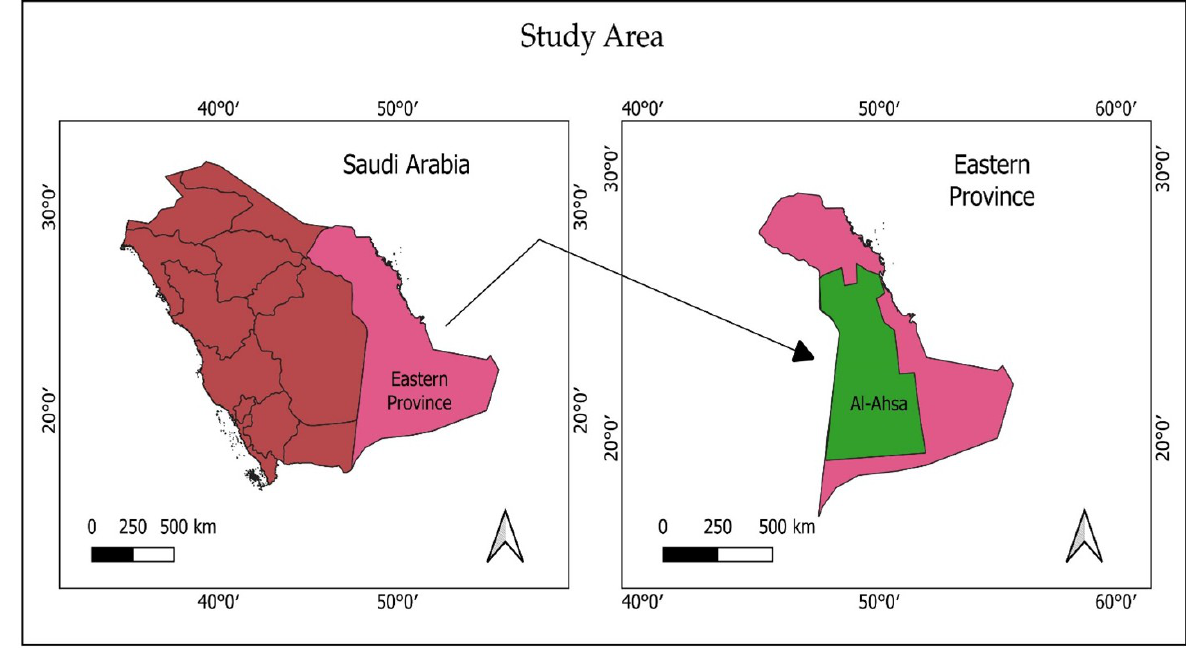
Fig 1. Map of the study